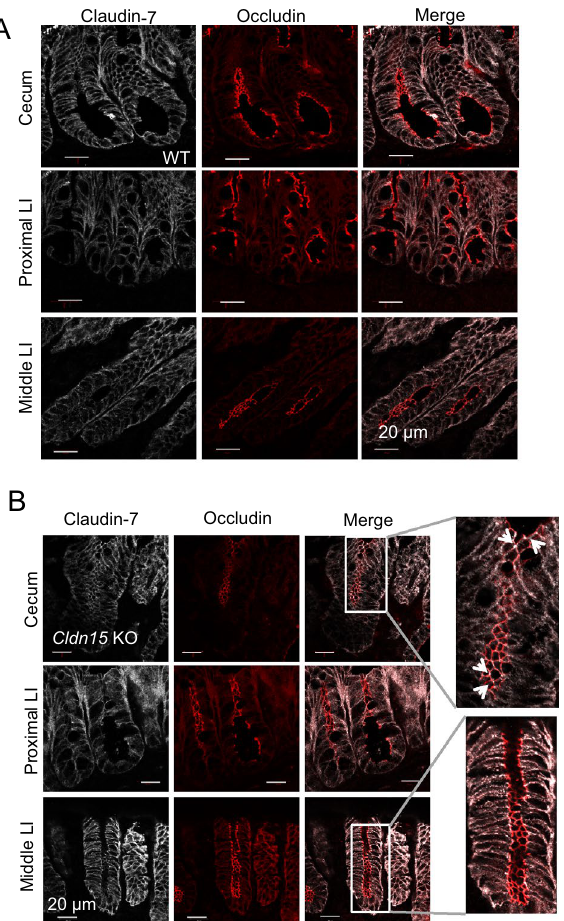
Figure 9. Immunofluorescence localization of claudin-7 in the cecum and large intestine. Representative immunofluorescence images showing claudin-7 (white) and occludin (red) antibody staining in the cecum, proximal and middle large intestine for ( A ) WT mice and ( B ) Cldn15 KO mice. Scale bar, 20 µm. Arrowheads point to localization of claudin-7 to the tight